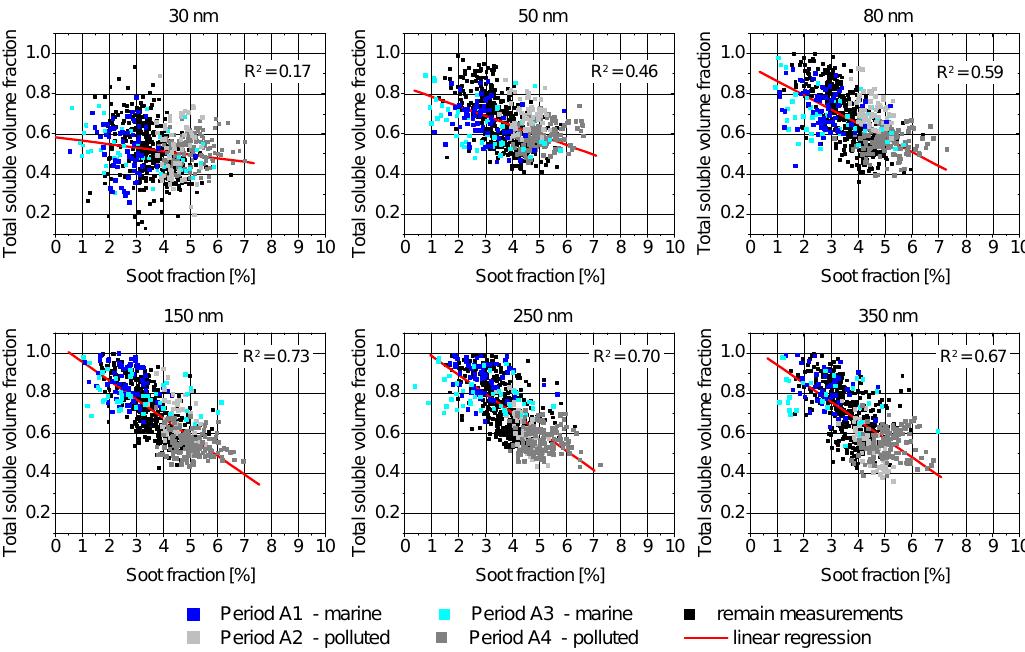
Fig. 8. Correlation between the soot mass fraction and the total soluble volume fraction ε tot — derived from H-TDMA data and the simplistic two-component model assuming insoluble matter and ammonium sulphate only (Sect. 3.2.1).